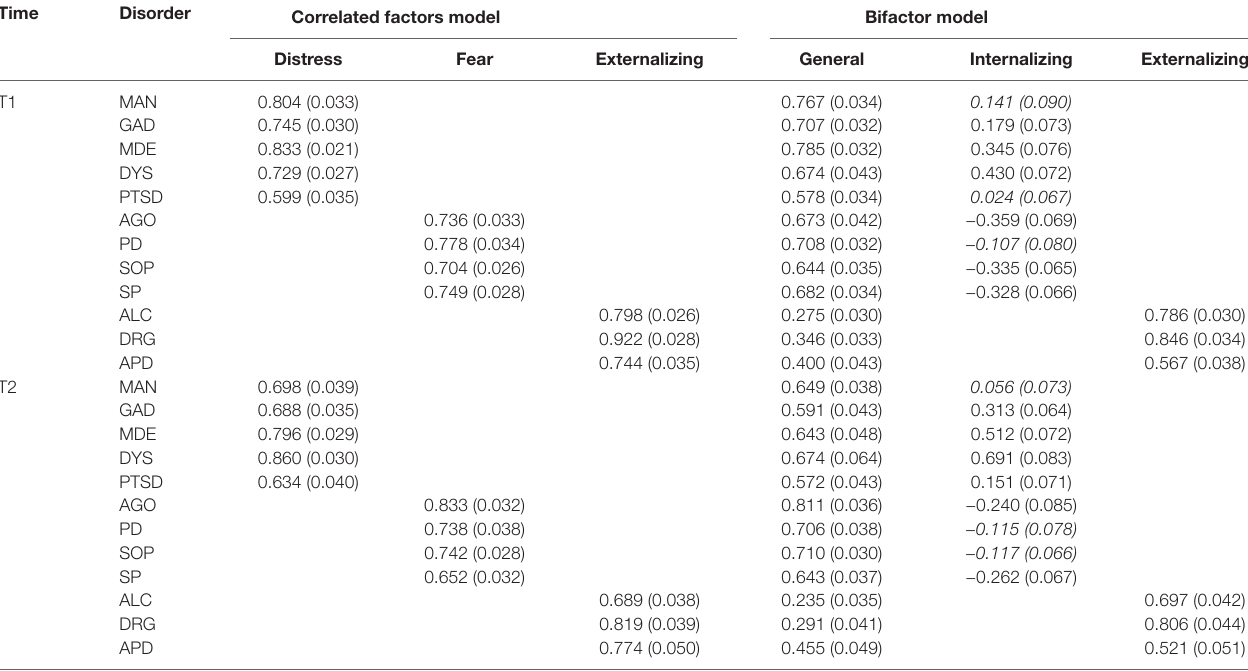
TABLE 2 | Unconstrained factor loadings (standard errors in parentheses) for the longitudinal correlated factors model and the longitudinal bifactor model. Time